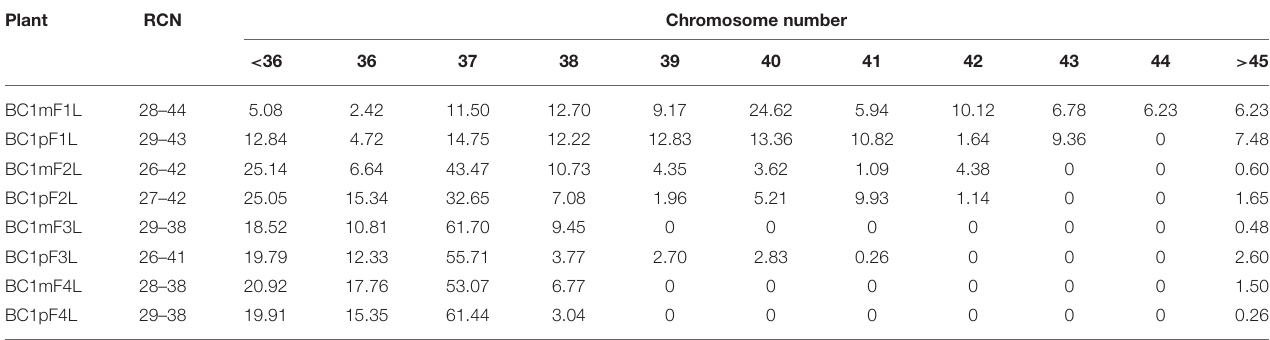
TABLE 2 | Average percentage of ovary cells with different chromosomes in the glufosinate-tolerant first- to fourth-generation progenies of the first backcross generation. Plant RCN Chromosome